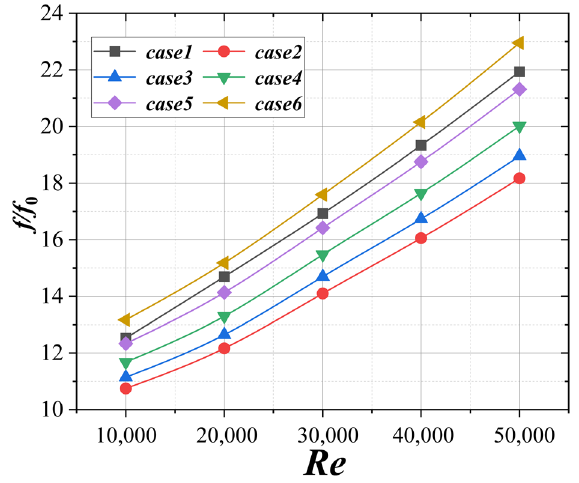
Figure 11. The variation of f/f 0 with Re in each case.